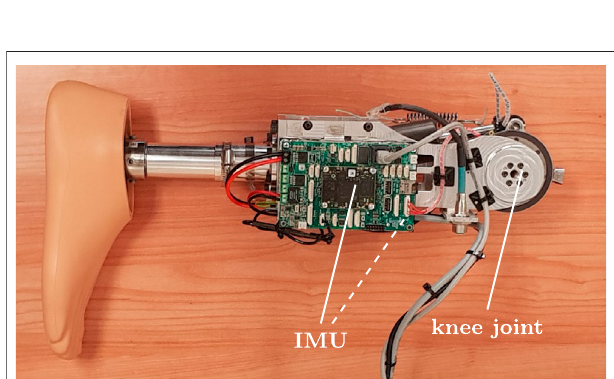
FIGURE 4| Research prototype ofa leg prosthesis. The IMU iscurrently centralized on the visible PCB. Referring to Figure 2 , moving the IMU to the bottom-right of the same PCB (indicated with a dashed line) already suggests signi fi cant shock reduction: a decent bene fi t for a minor cost.